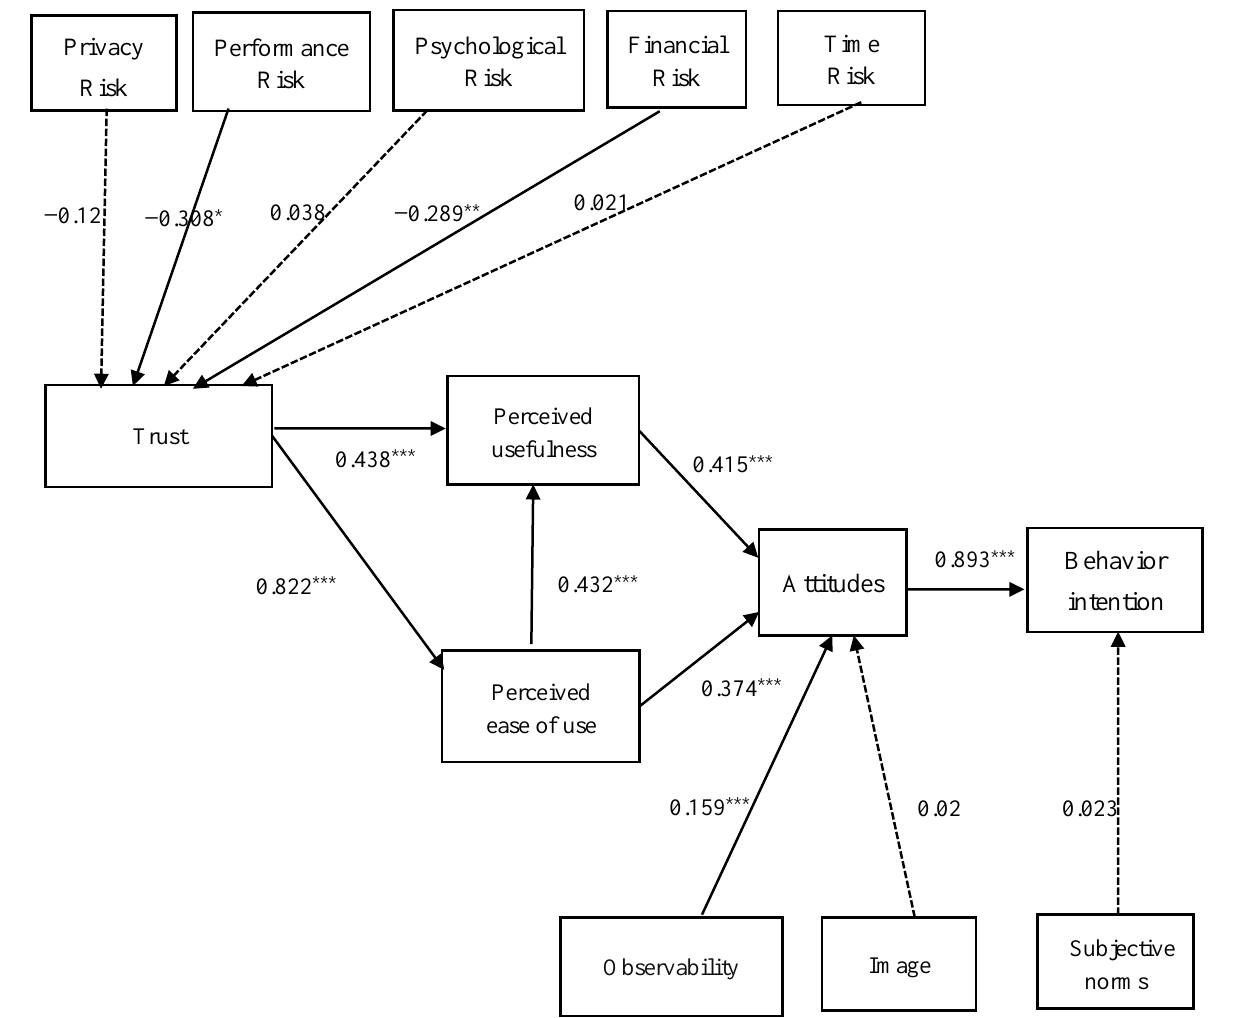
Figure 1. Estimated model architecture. * p < 0.05; ** p < 0.01; *** p < 0.001.